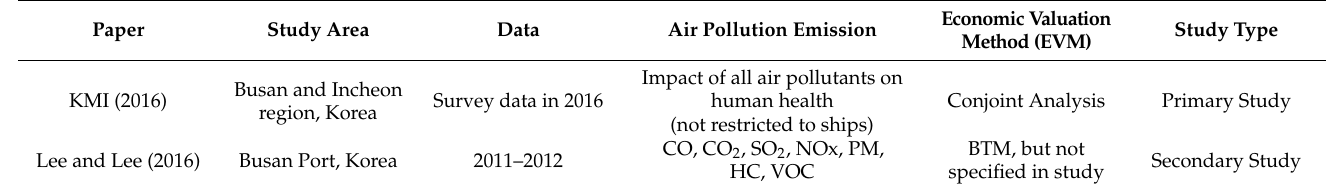
Table 4. Studies on estimating the environmental cost of ship emissions in